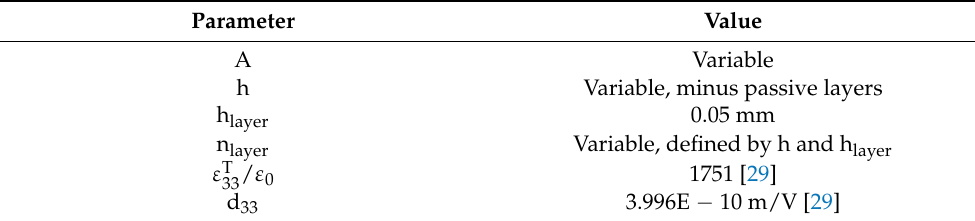
Table 2. Parameters defining the piezoelectric element ( ε 0 = 8.854E − 12 As/(Vm)).